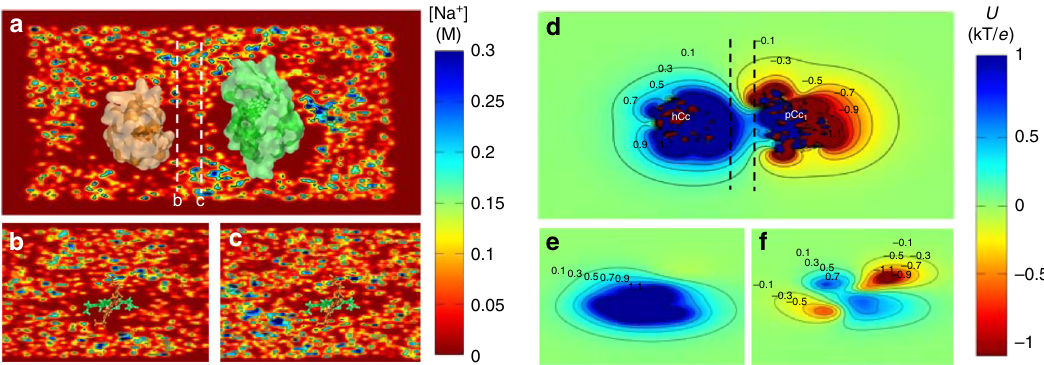
Fig. 2 Ion concentration and electrostatic potential around hC c and pC c 1 from MD simulations. a Side view of the averaged sodium concentration (M) map, which is relatively low in the region between the proteins, thereby reducing ionic charge screening. hC c (orange) and pC c 1 (green) proteins are superimposed for visualization purposes. Each contour line corresponds to 0.15 M. b , c Example cross sections corresponding to the dashed white lines in a . The two planes are separated 0.6 nm. The corresponding heme groups (hC c protein, orange, and pC c 1 protein, green) are also placed on the fi gure for visualization purposes. d Side view of the equipotential lines from − 1.1 kT/ e (red) to 1.1 kT/ e (blue) calculated by Poisson – Boltzmann equation (APBS method); ion concentration is 50 mM, pH = 6.5. Each contour line corresponds to 0.2 kT/ e . e , f Cross sections corresponding to the dashed white lines in d , the two planes are separated 0.6